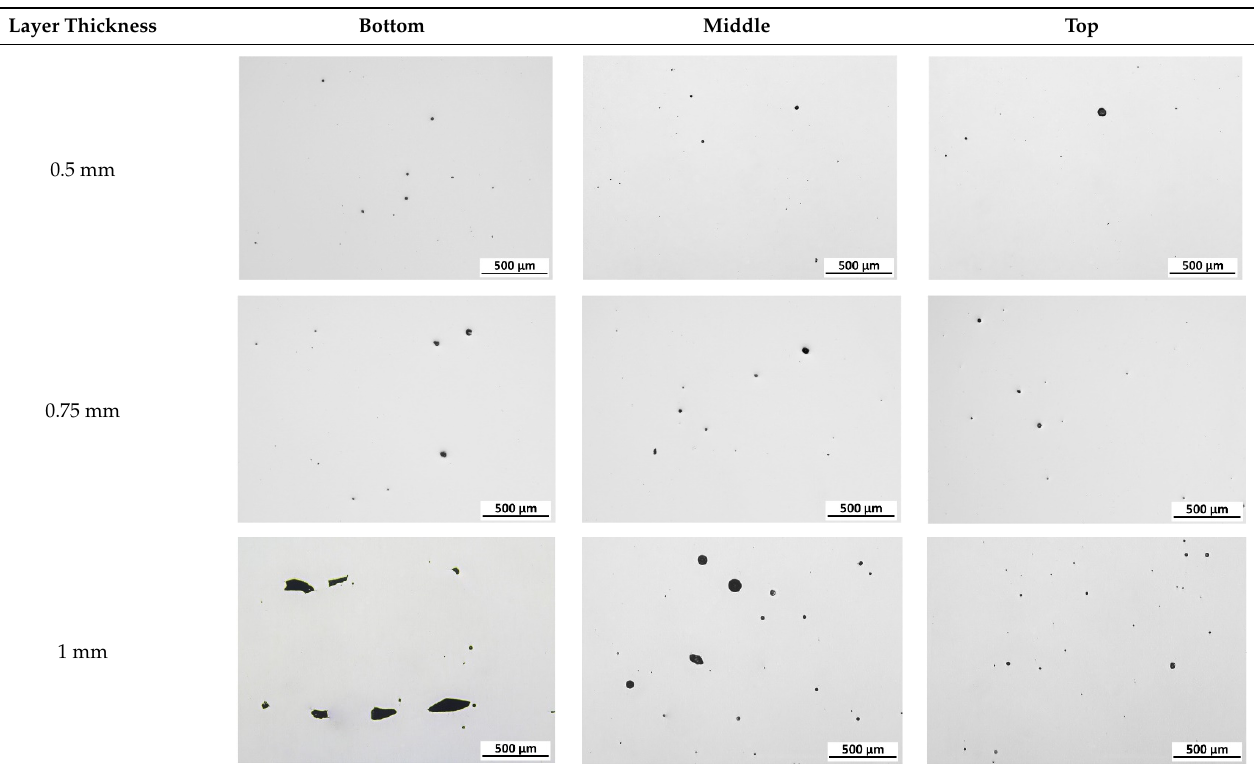
Table 5. Porosity of parts manufactured by LENS ® .